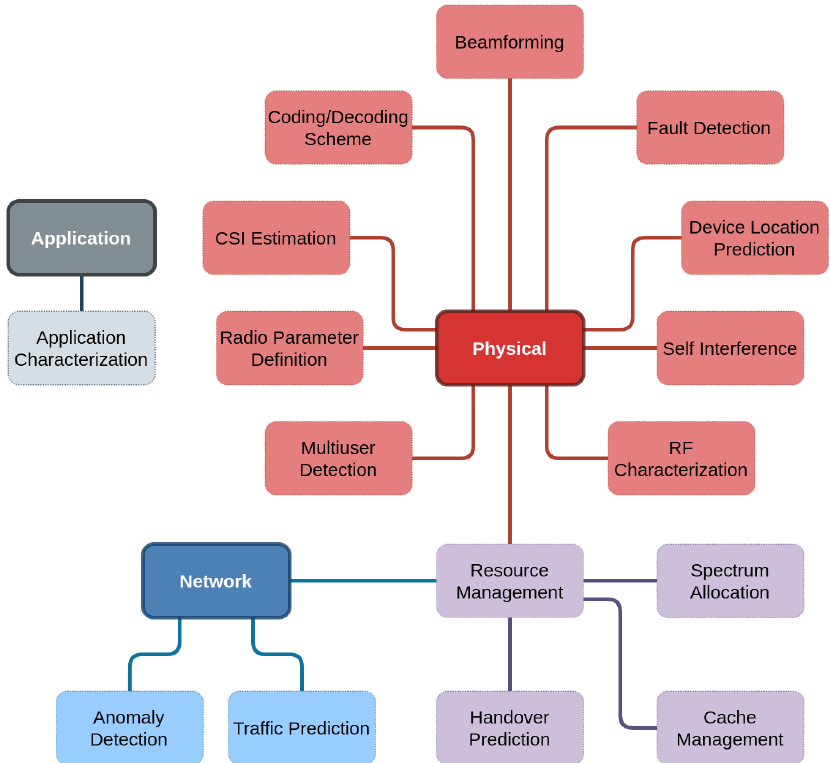
Figure 1. The problems related to 5G addressed in the works